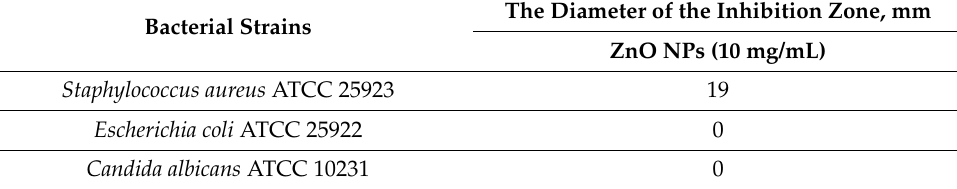
Table 2. The diameters of the inhibition zones.